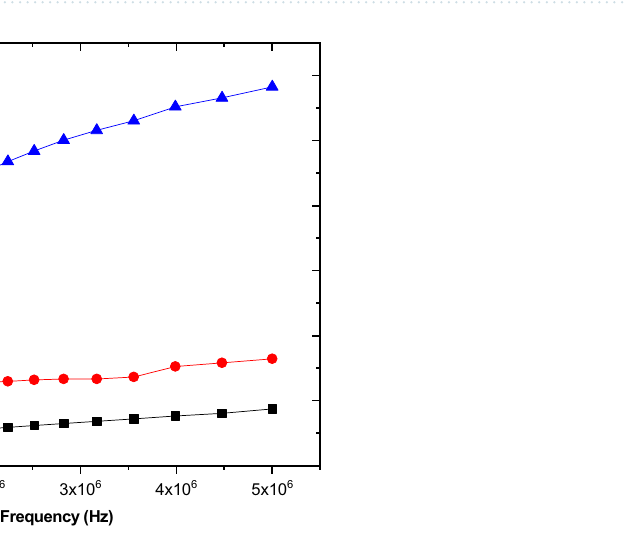
Figure 9. ( a ) The dielectric constant and ( b ) the dielectric loss as a function of frequency at different temperatures.